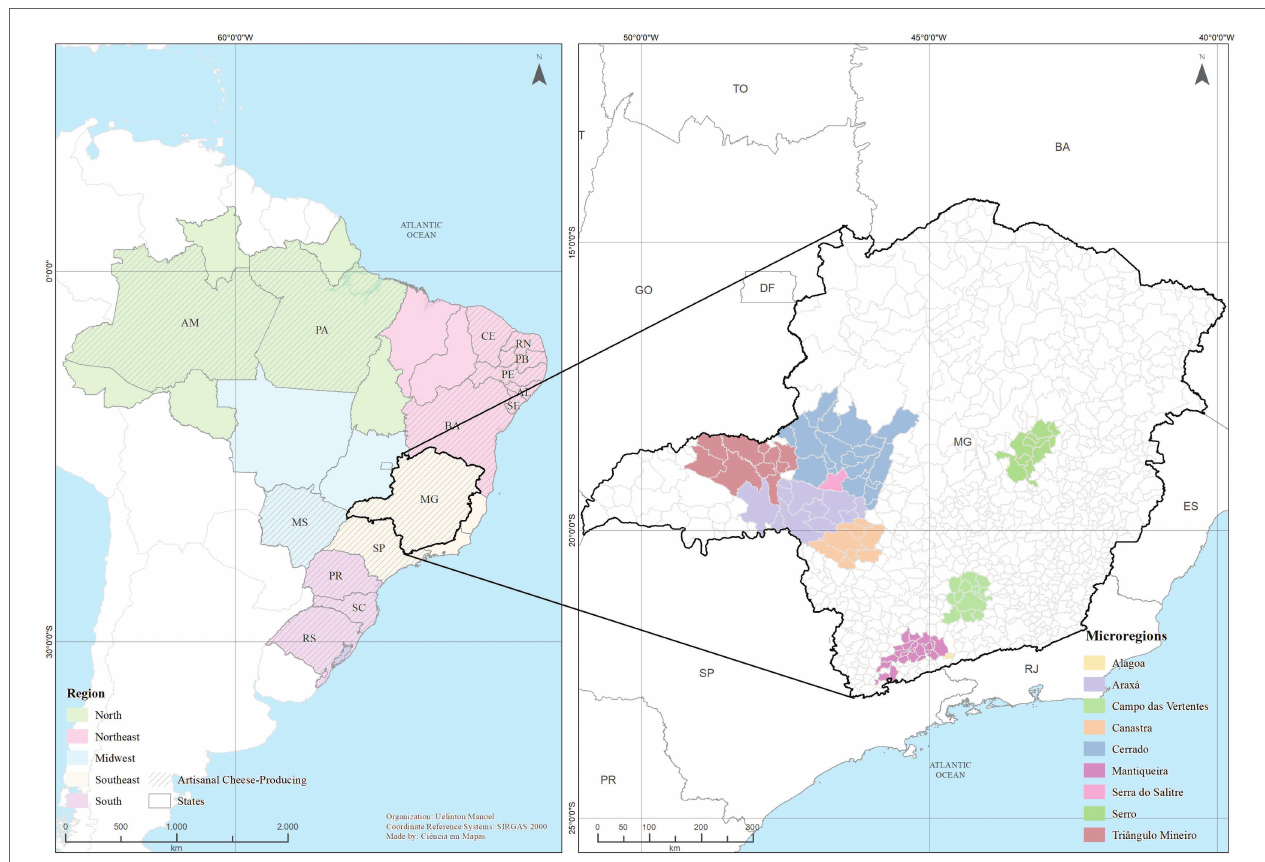
FIGURE 1 | States within each Brazilian region where the main Brazilian artisanal cheeses are produced. North : AM, Amazonas; PA, Pará; Northeast : AL, Alagoas; BA, Bahia; CE, Ceará; PB, Paraíba; PE, Pernambuco; RN, Rio Grande do Norte; SE, Sergipe; Southeast : MG, Minas Gerais; SP, São Paulo; Central-West : MS, Mato Grosso do Sul; South : PR, Paraná, RS, Rio Grande do Sul; SC, Santa Catarina. The inset highlights the nine artisanal cheese producing microregions in the state of Minas Gerais